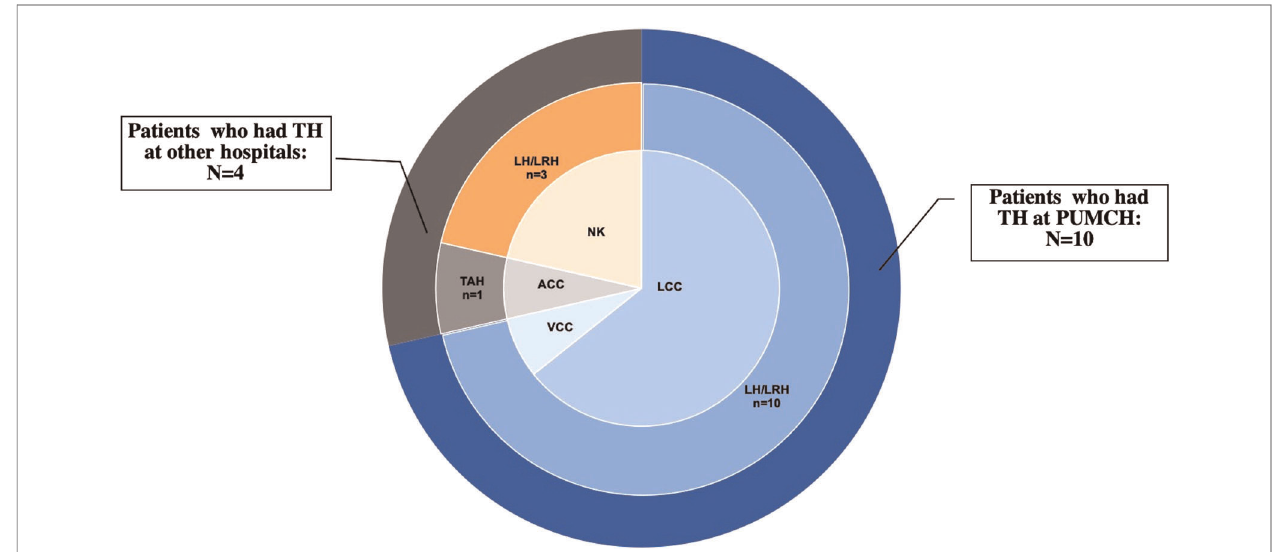
FIGURE 1 | The distribution of different types of TH and cuff